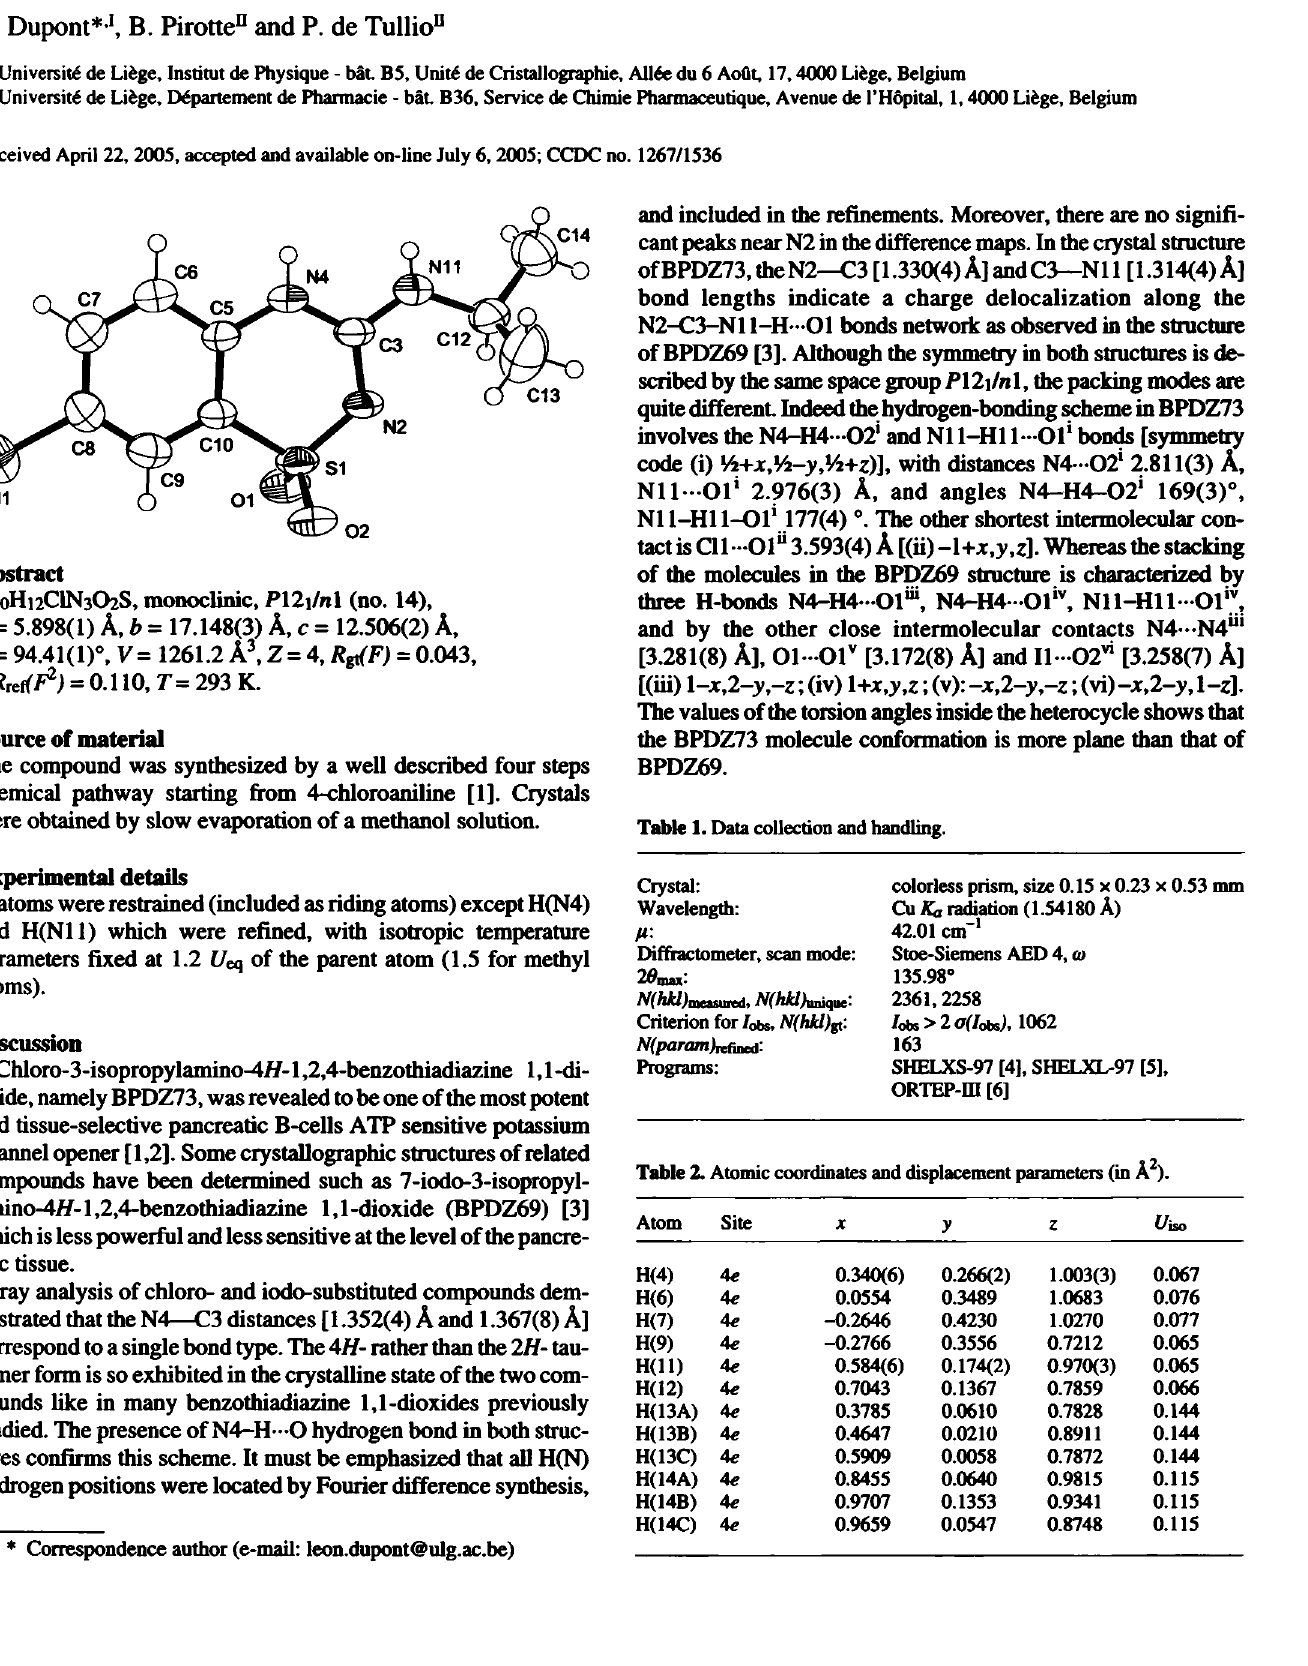
Table 2. Atomic coordinates and displacement parameters (in A 2